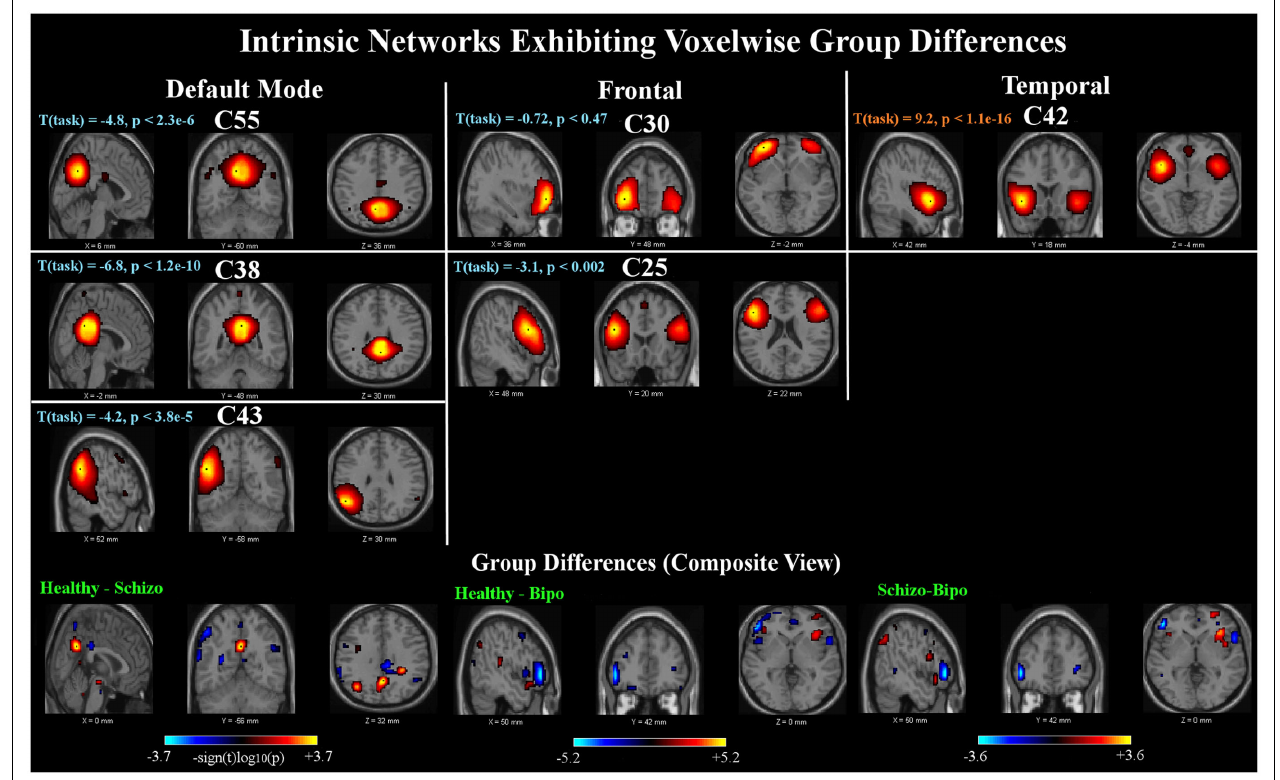
composite maps of the group differences for the Healthy – Schizo (left), Healthy – Bipo (middle), and Schizo – Bipo (right) contrasts (thresholded at p < 0.05, corrected for multiple comparisons). Composite maps for each contrast are created by taking the maximum significant value (over the six components) at each